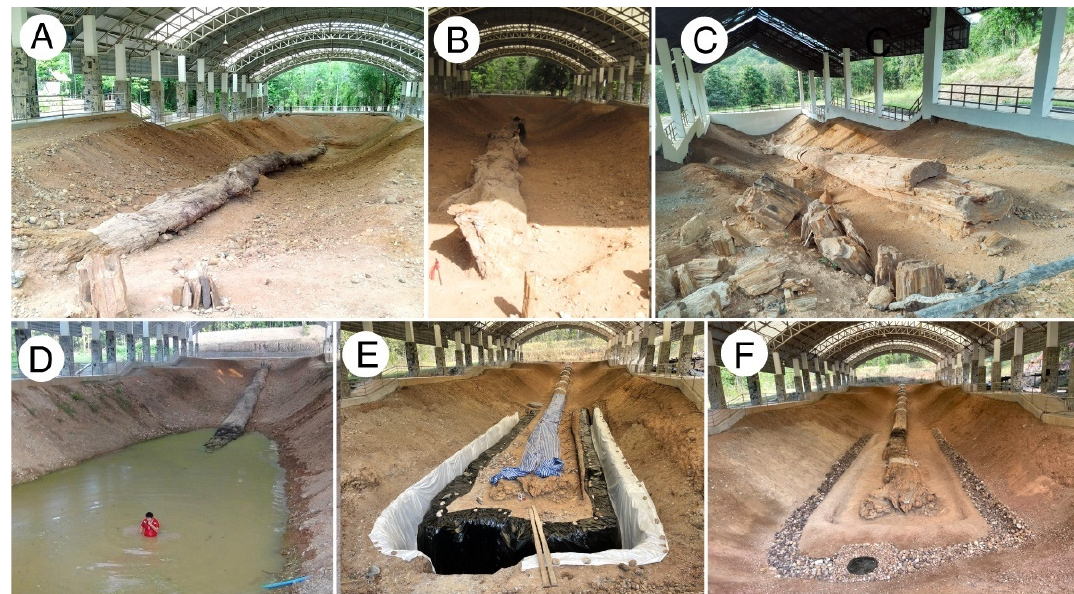
Figure 23. Imperfections and improvements of permanent shelters. ( A ) BT-1, showing discol- oration from chemical application on the top and microorganisms at the middle. ( B ) BT-1 showing contrast between shade and sunlight. ( C ) The narrow roof of the BT-7 shelter allows sunlight ex- posure to most of the trunk in late afternoon. ( D ) Monsoon flooding of BT-1 shelter, October, 2011. ( E ) 2021 BT-1 shelter Installation of water barrier fabric: geotextile (white) and geomembrane (black). ( F ) Completed water barrier, with gravel filling. ( E , F ) photos courtesy of Phoobet